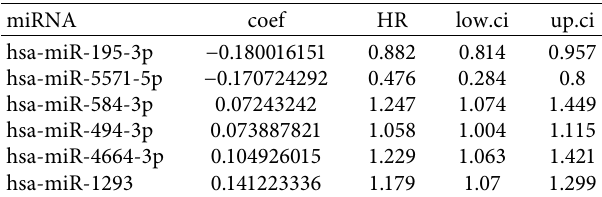
Figure 3: Univariate Cox regression analysis and Kaplan–Meier test on the selected differentially expressed miRNAs to further filter out eight miRNAs that are significantly related to OS. AB: 13 candidate microRNAs that are differentially expressed in tumors and normal tissues and are significantly related to OS ((a) expression heatmap in TCGA, (b) expression heatmap in CPTAC-3); CD: 13 candidate miRNAs in normal tissues (para-cancerous tissues) and tumor tissues. (c) Expression in the TCGA data set, (d) expression in the CAPAC-3 data set. Table 1: Correlation coefficients and HR of the six miRNA genes in the prognostic